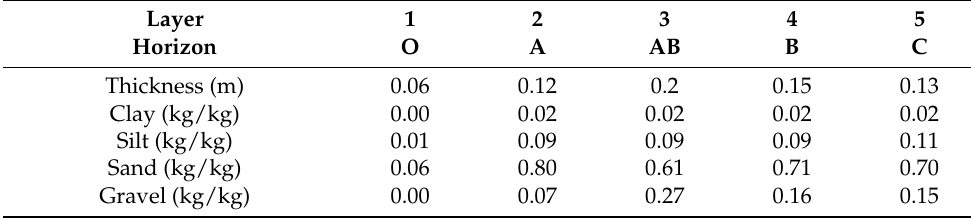
Table A3. Soil parameters for the Central